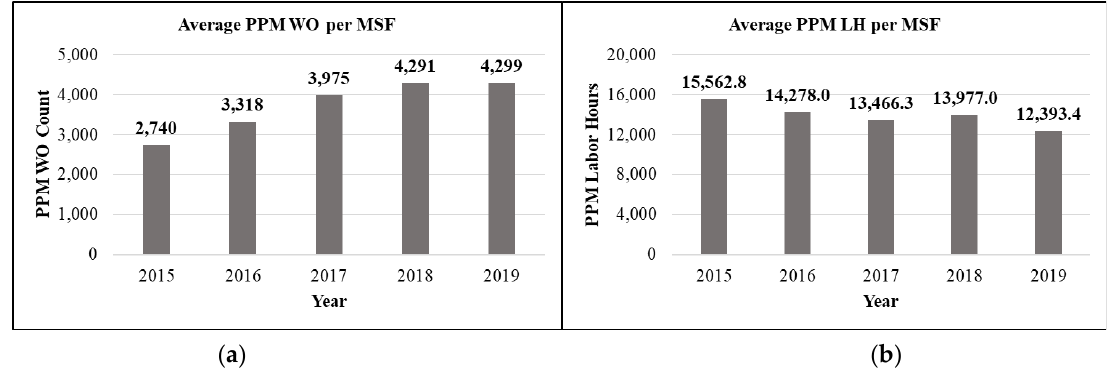
Figure 7. Five-year trend of PPM: ( a ) Work Order Counts; ( b ) Labor Hours.